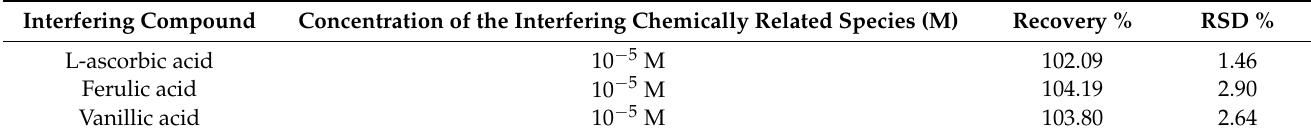
Table 8. The interference of some chemically related species on the quantitative determination of CGA. Interfering Compound Concentration of the Interfering Chemically Related Species (M) The tolerance limit was calculated, with the following results: 5 × 10 − 5 M for